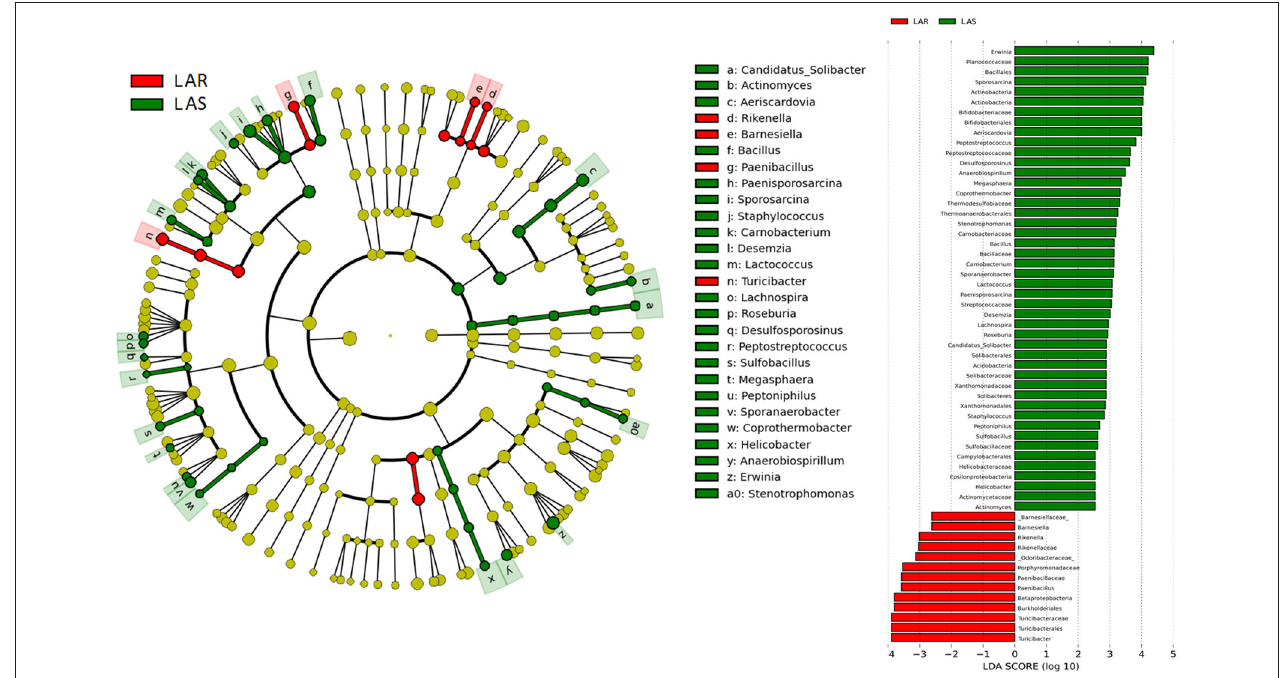
FIGURE 6 | LEfSe identified taxons for LAS and LAR. (Left) Taxonomic cladogram. Taxa enriched in LAR or LAS are colored by red or green, respectively. (Right) LAS-enriched taxa are shown with a positive LDA score (green), and taxa enriched in LAR are shown with a negative score (red). Only taxa meeting an LDA significant threshold > 2 and p < 0.05 are shown.